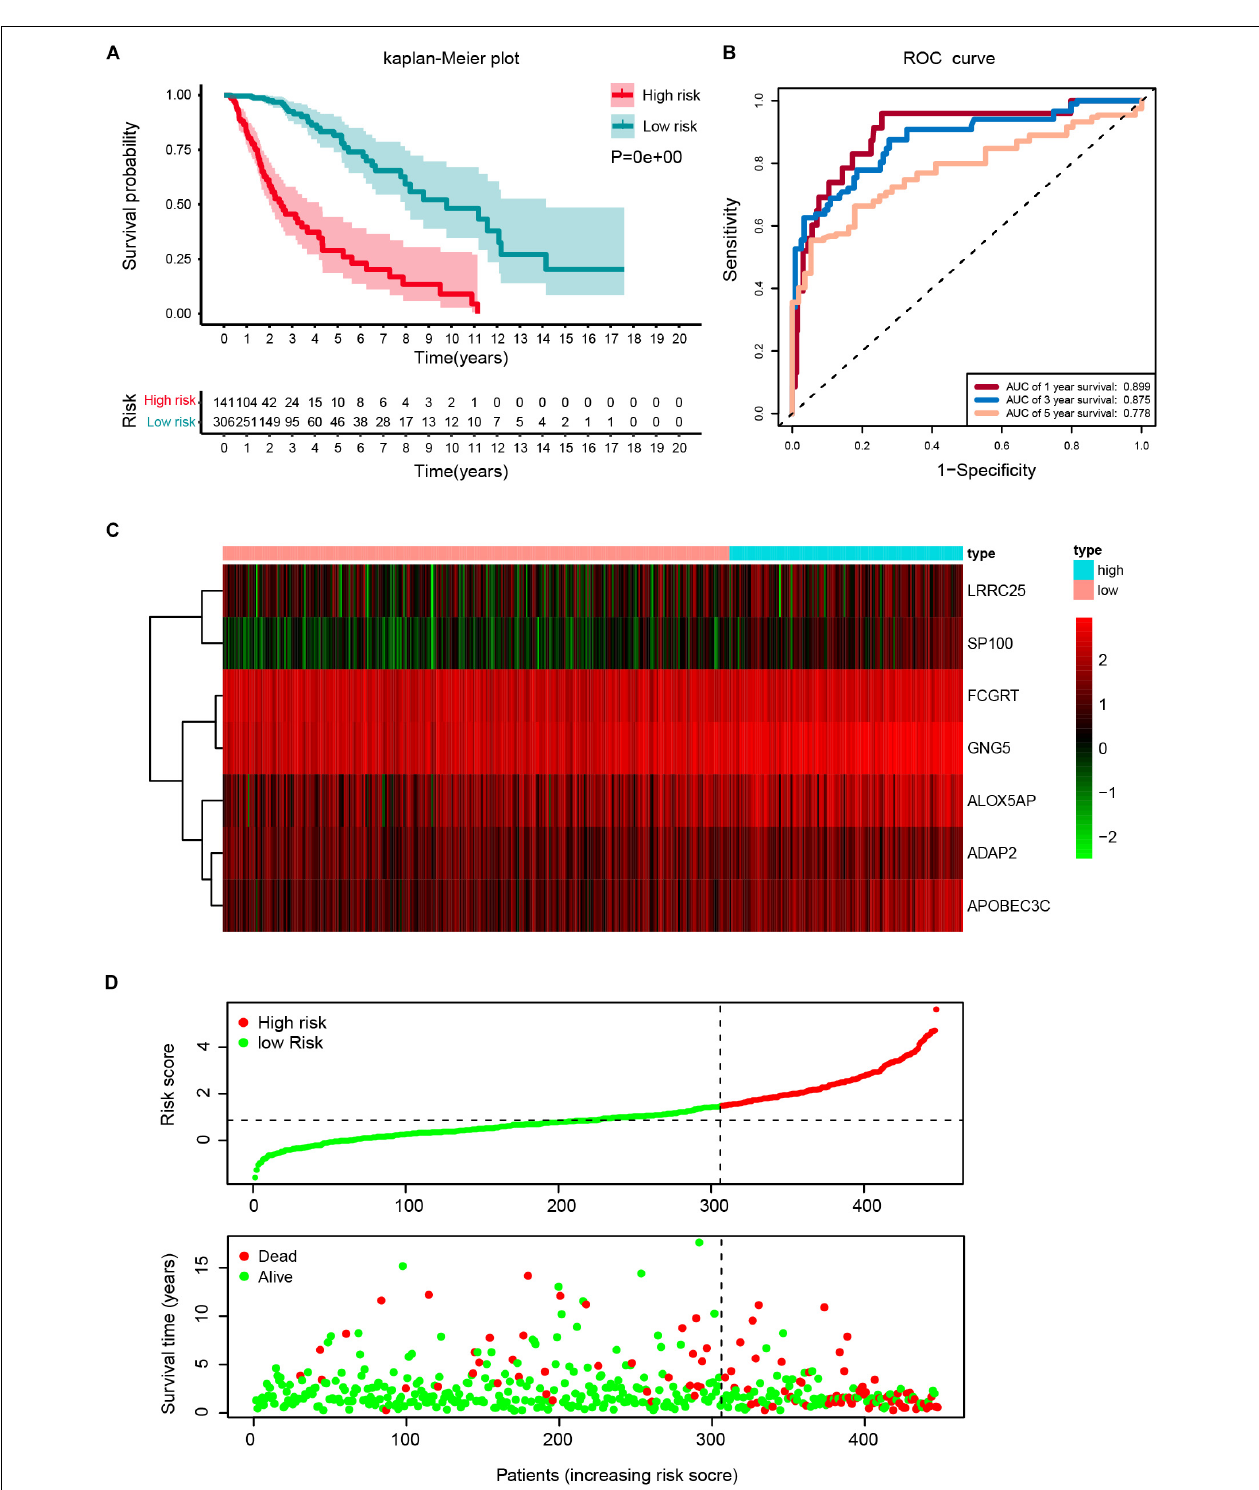
FIGURE 5 | Construction of a risk score based on the seven stemness indices-related gene signature in the TCGA cohort. (A) Kaplan-Meier analysis of OS for low-risk and high-risk patients in the training cohort. Additionally, the table indicating the number at risk for each group at corresponding time points. (B) The time-dependent receiver operating characteristics (ROC) curve for 1-, 3-, and 5-year OS predictions for stemness-index related risk signature. (C) Heatmap showing the distribution of the expression of the seven genes of the stemness index in the TCGA cohort. (D) Risk plot presenting each point sorted based on risk score, representing one patient. Green and red points represent patients with low- and high-risk, respectively.